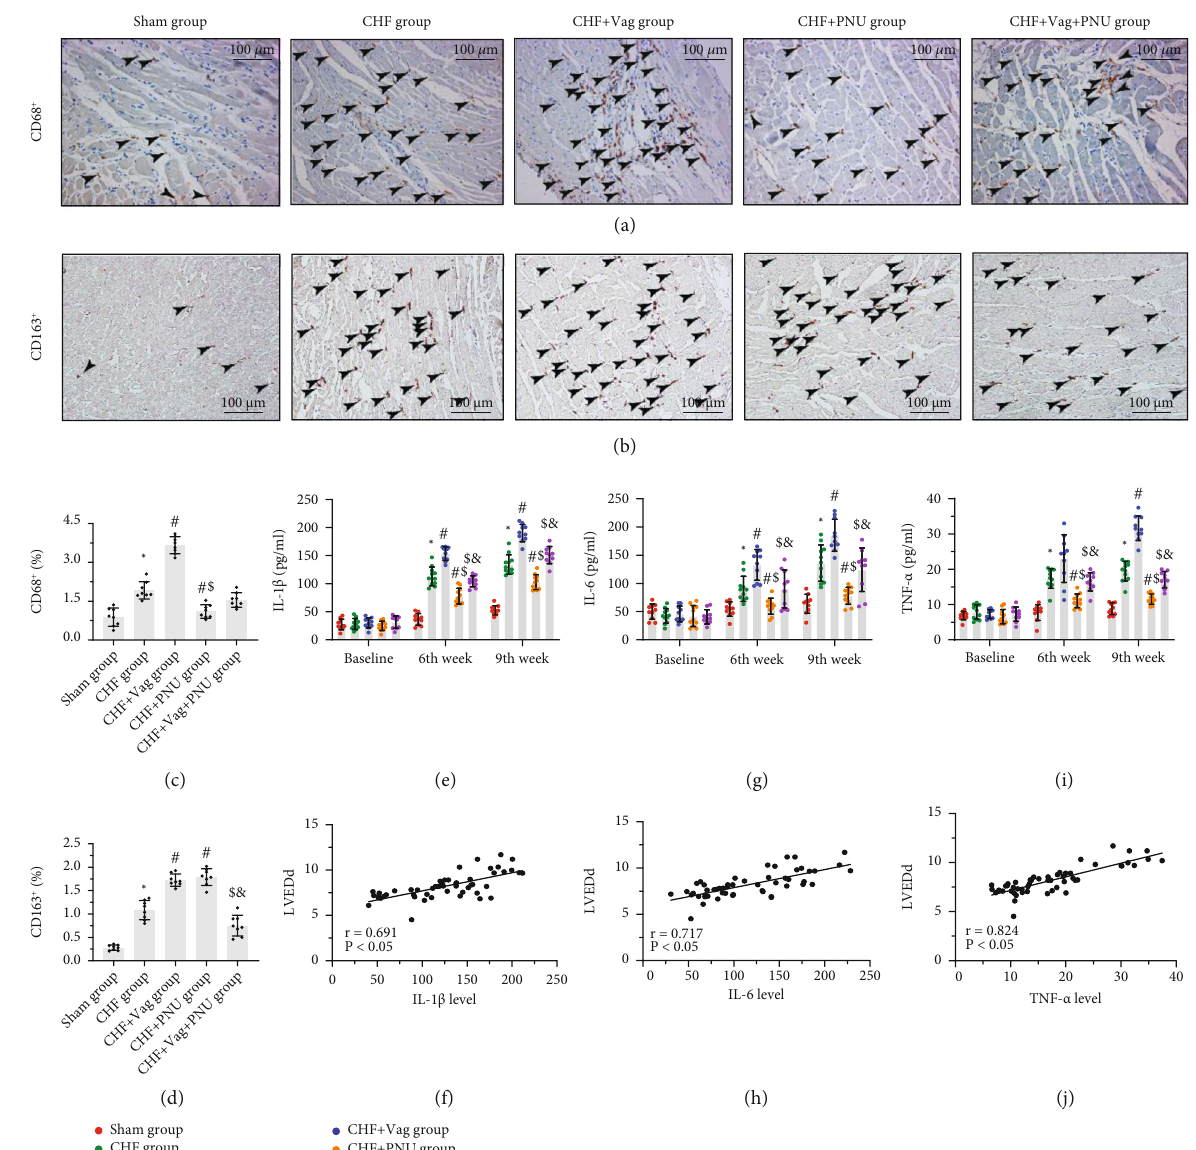
Figure 3: E ff ects of cholinergic elicitation on systemic in fl ammation and cardiac macrophage in fi ltration. Typical images of CD68 + staining (a) ( × 20) and CD163 + staining (b) ( × 20) among fi ve groups. Quantitative analysis of immunohistochemical results (c, d). Comparisons of IL-1 β (e), IL-6 (g), and TNF- α (i) among fi ve groups at three time points at baseline, the 6 th week, and the 9 th week. Correlations of LVEDd values of the 9 th week with IL-1 β (f), IL-6 (h), and TNF- α (j) levels of the 9 th week. ∗ P < 0 : 05 vs. Sham group. # P < 0 : 05 vs. CHF group. $ P < 0 : 05 vs. CHF+Vag group. & P < 0 : 05 vs CHF+PNU group. IL-1 β : interlukin-1 β ; IL-6: interlukin-6; TNF- α : tumor necrosis factor α